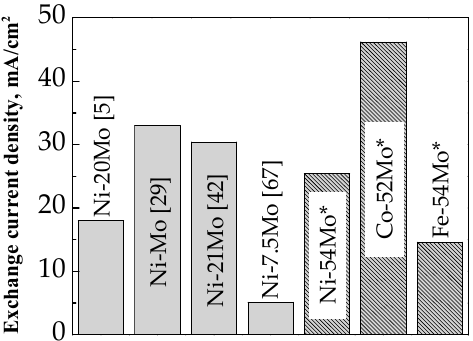
Figure 5. The comparison of apparent exchange current densities ( i 0 ) towards the HER on Mo alloys with iron group metals determined in this study (*) with the published data. The experiments were performed in NaOH at 60–65 °C. The composition of alloys is given in at.%.